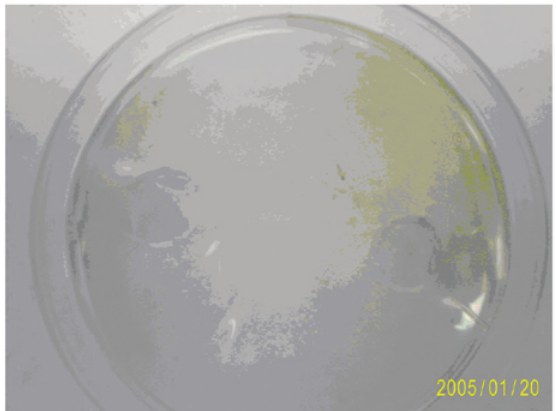
Figure 2: After 26 days of incubation the majority of samples, such as the Baucsh and Lomb (expiry date 2003) blister packed contact lens, showed no signs of bacterial contamination. (Please ignore the date due to incorrect camera settings.)